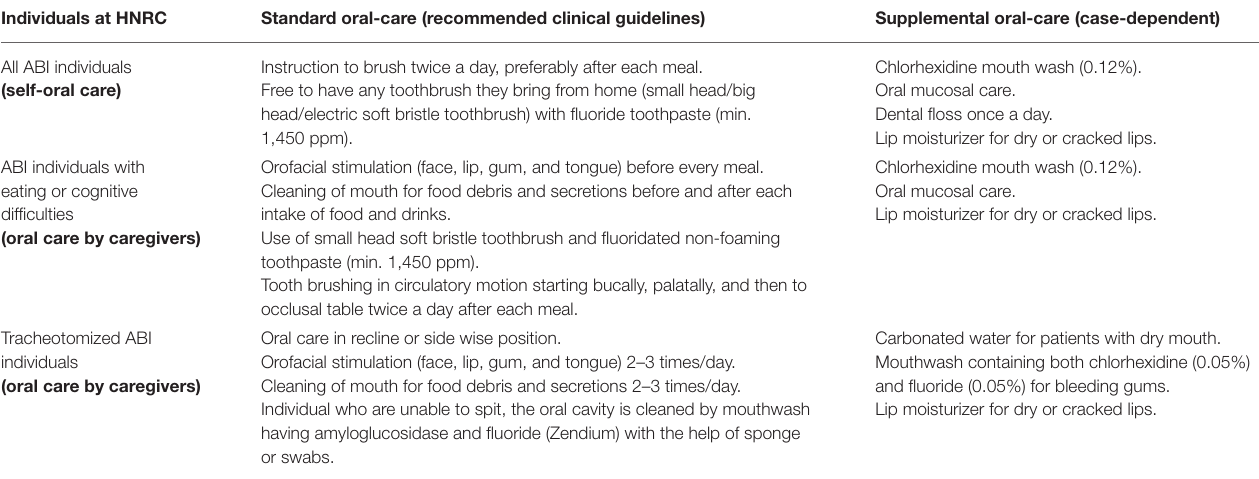
TABLE 1 | Standard oral care program at HNRC. Individuals at HNRC Standard oral-care (recommended clinical guidelines)